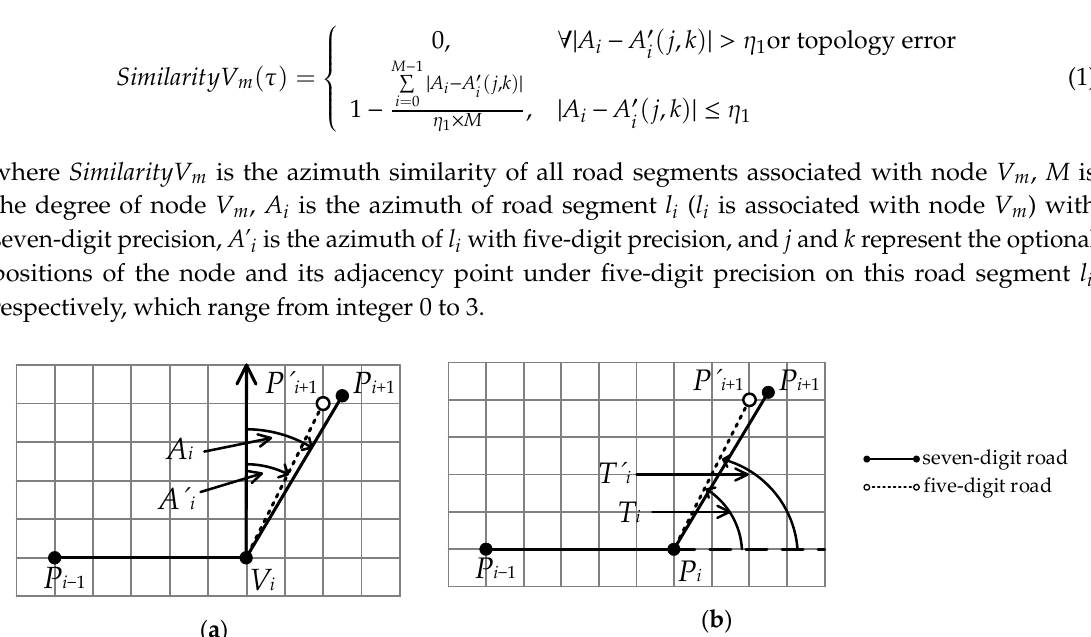
( b ) Figure 3. Representation model of a road network: ( a ) road and ( b ) road network G . 2.2. Constraints on Road Generalization The planar coordinates of points in roads can be represented by ( ψ , r ), where ψ is the longitude, and r is the latitude. For example, (15.1234567°, 16.1234567°) represents the location of a planar point, where 15.1234567° is the longitude and 16.1234567° is the latitude. The value 15.1234567° is a number with seven decimal places. When reducing road data precision, (15.1234567°, 16.1234567°) must be rounded up to five decimal places, e.g., (15.12346°, 16.12346°). The grid model is used to represent the different precision roads. In Figure 1, the blue line represents a road with seven-digit